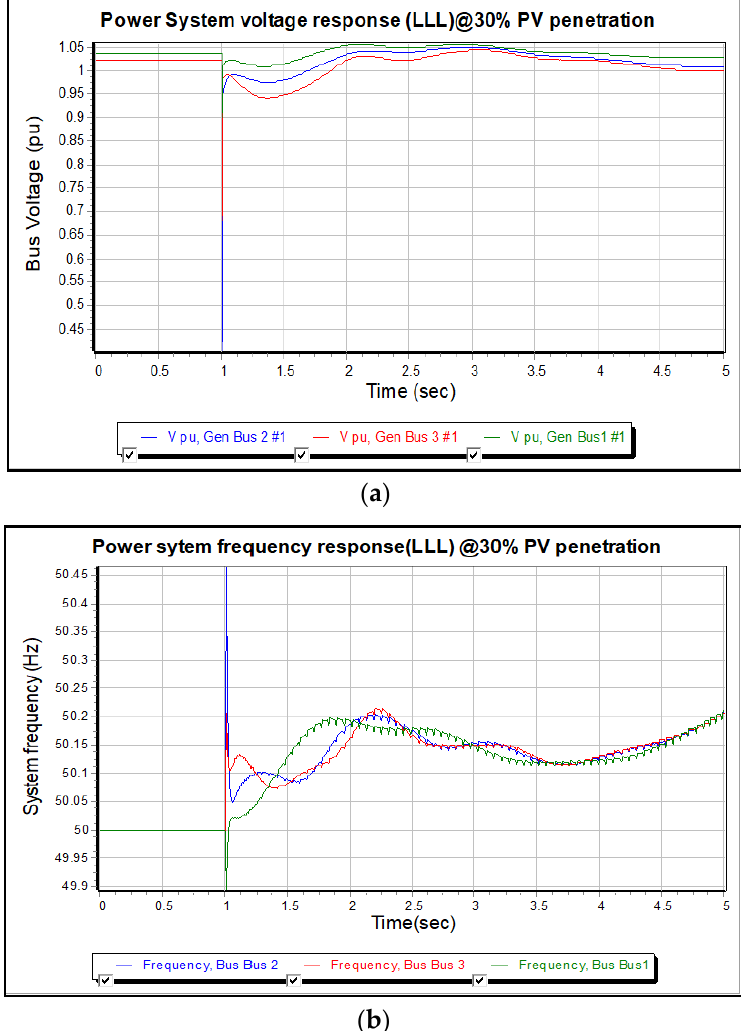
Figure 7. 3- ϕ fault simulation without flywheel at 30% PV Penetration: ( a ) power system voltage response; ( b ) power system frequency response .